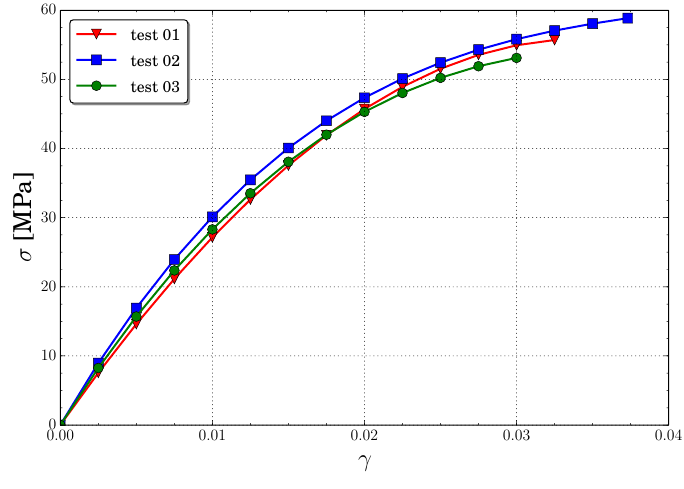
Figure 2. Stress-strain curves obtained from uniaxial tension